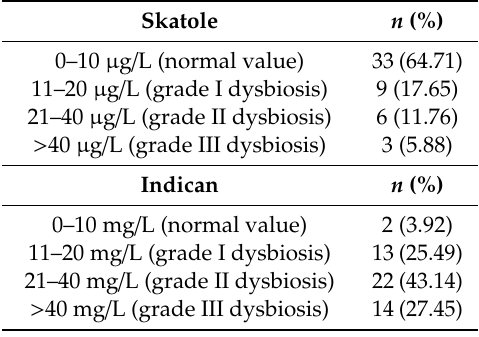
Table 3. Absolute and percent distribution of pre-treatment levels of skatole and